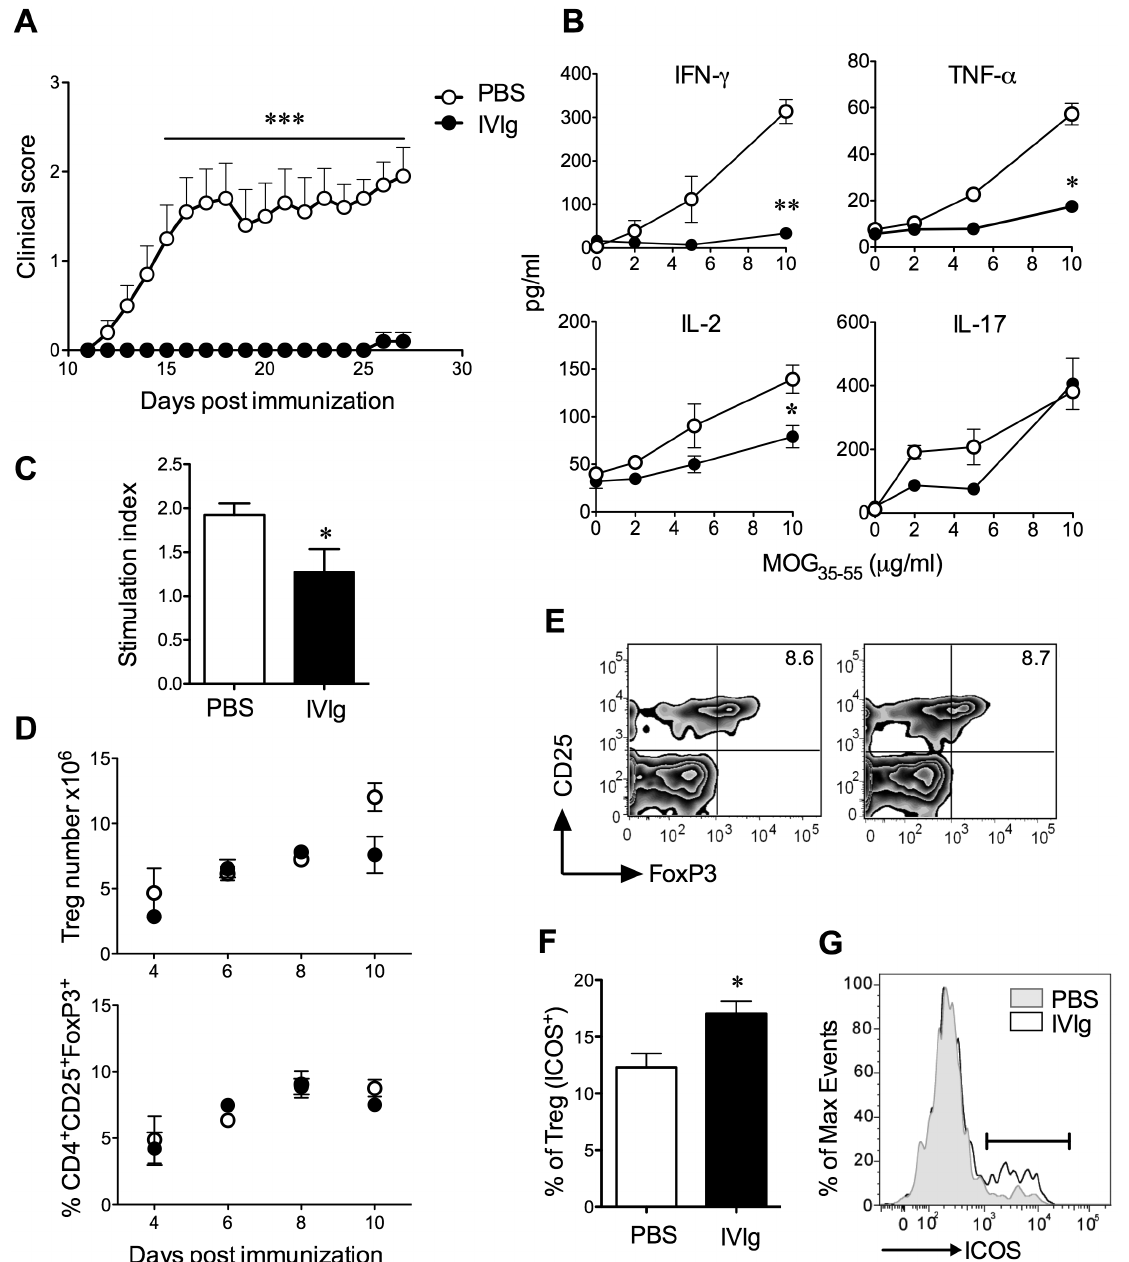
Figure 1. IVIg inhibits EAE by preventing the expansion and Th1 and Th17 cytokine production by MOG 35–55 reactive T cells and by increasing ICOS expression by Tregs. EAE was induced in female C57BL/6J mice by immunization with MOG 35–55 and CFA plus pertussis toxin and mice were administered daily i.p. injections of IVIg or 1 6 PBS beginning at day of disease induction (N=12/group). At 10 post-immunization, spleens were collected from N=2/mice per group and were pooled for ex vivo stimulation with MOG 35–55 . Remaining mice (N=10/group) were followed for clinical signs. A , shows the mean + SEM severity of clinical signs of mice in each group over the period of observation. B , shows the levels of IL-2 (at 48 h), IFN- c , TNF- a and IL-17A (at 72 h) in splenocyte cultures as measured by ELISA. Values are means + SEM of triplicate cultures in one representative experiment. C , shows proliferation of cells in triplicate splenocyte cultures in response to MOG 35–55 (5 m g/ml) was measured in counts per minute (cpm) and was expressed relative to the cpm in the non-peptide-containing wells. This ratio is the stimulation index. In A–C , data are representative of 2–3 independent experiments. D–G , represents a separate study where C57BL6/J mice were immunized with MOG 35–55 /CFA (without pertussis toxin) and were treated with PBS or IVIg daily. After 4, 6, 8, or 10 days, spleens were harvested, were processed into a single cell suspension for the determination of CD4, CD25, FoxP3, and ICOS using flow cytometry. D shows the frequency and number of CD4 + CD25 + FoxP3 + cells at these different time points after immunization. Values are means 6 SEM 3 individual mice per group at each time point. E shows representative staining of FoxP3 and CD25 in the live, CD4 + gate while G shows representative ICOS staining of the live CD4 + CD25 + FoxP3 + population at day 6 post-immunization (peak of ICOS expression, data not shown). F Shows the mean 6 SEM percent of Tregs that were positive for ICOS staining. Values are means + SEM percentages obtained in 3 individual mice per group. ***p , 0.001, **p , 0.01, *p , 0.05 as determined using a t-test or Mann-Whitney U test.